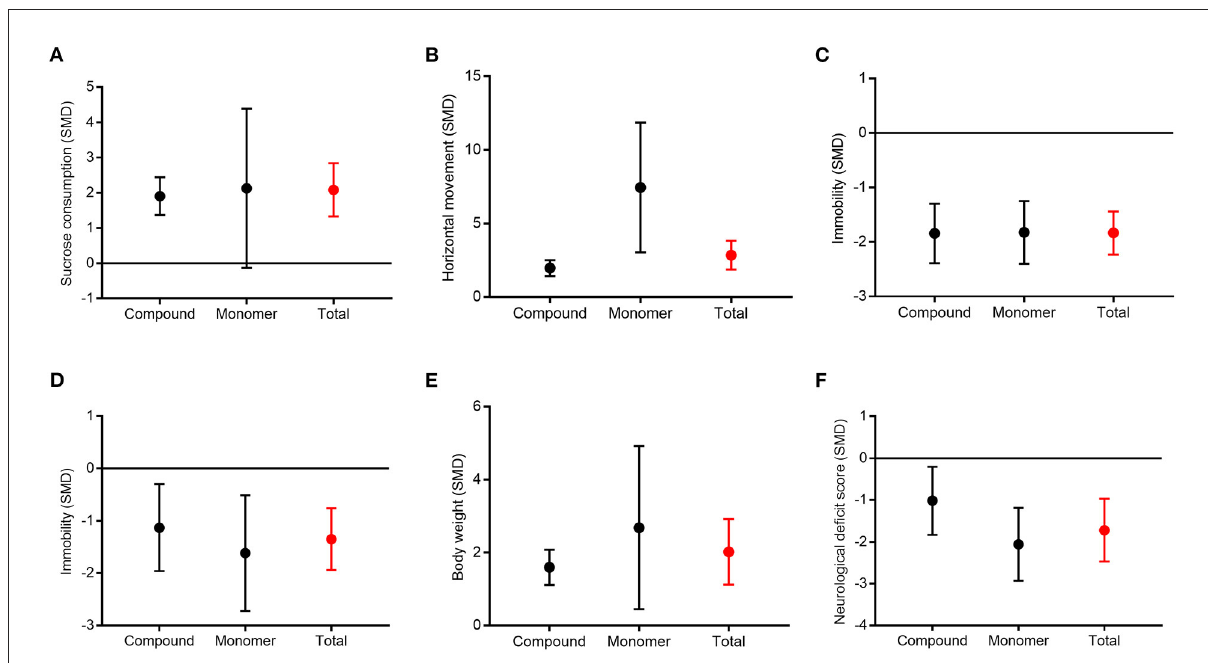
FIGURE8 Subgroup analysis between compound and monomer of CHM. Sucrose preference test (A) , open-field test (B) , forced swimming test (C) , tail suspension test (D) , body weight (E) , and neurological deficit score (F)